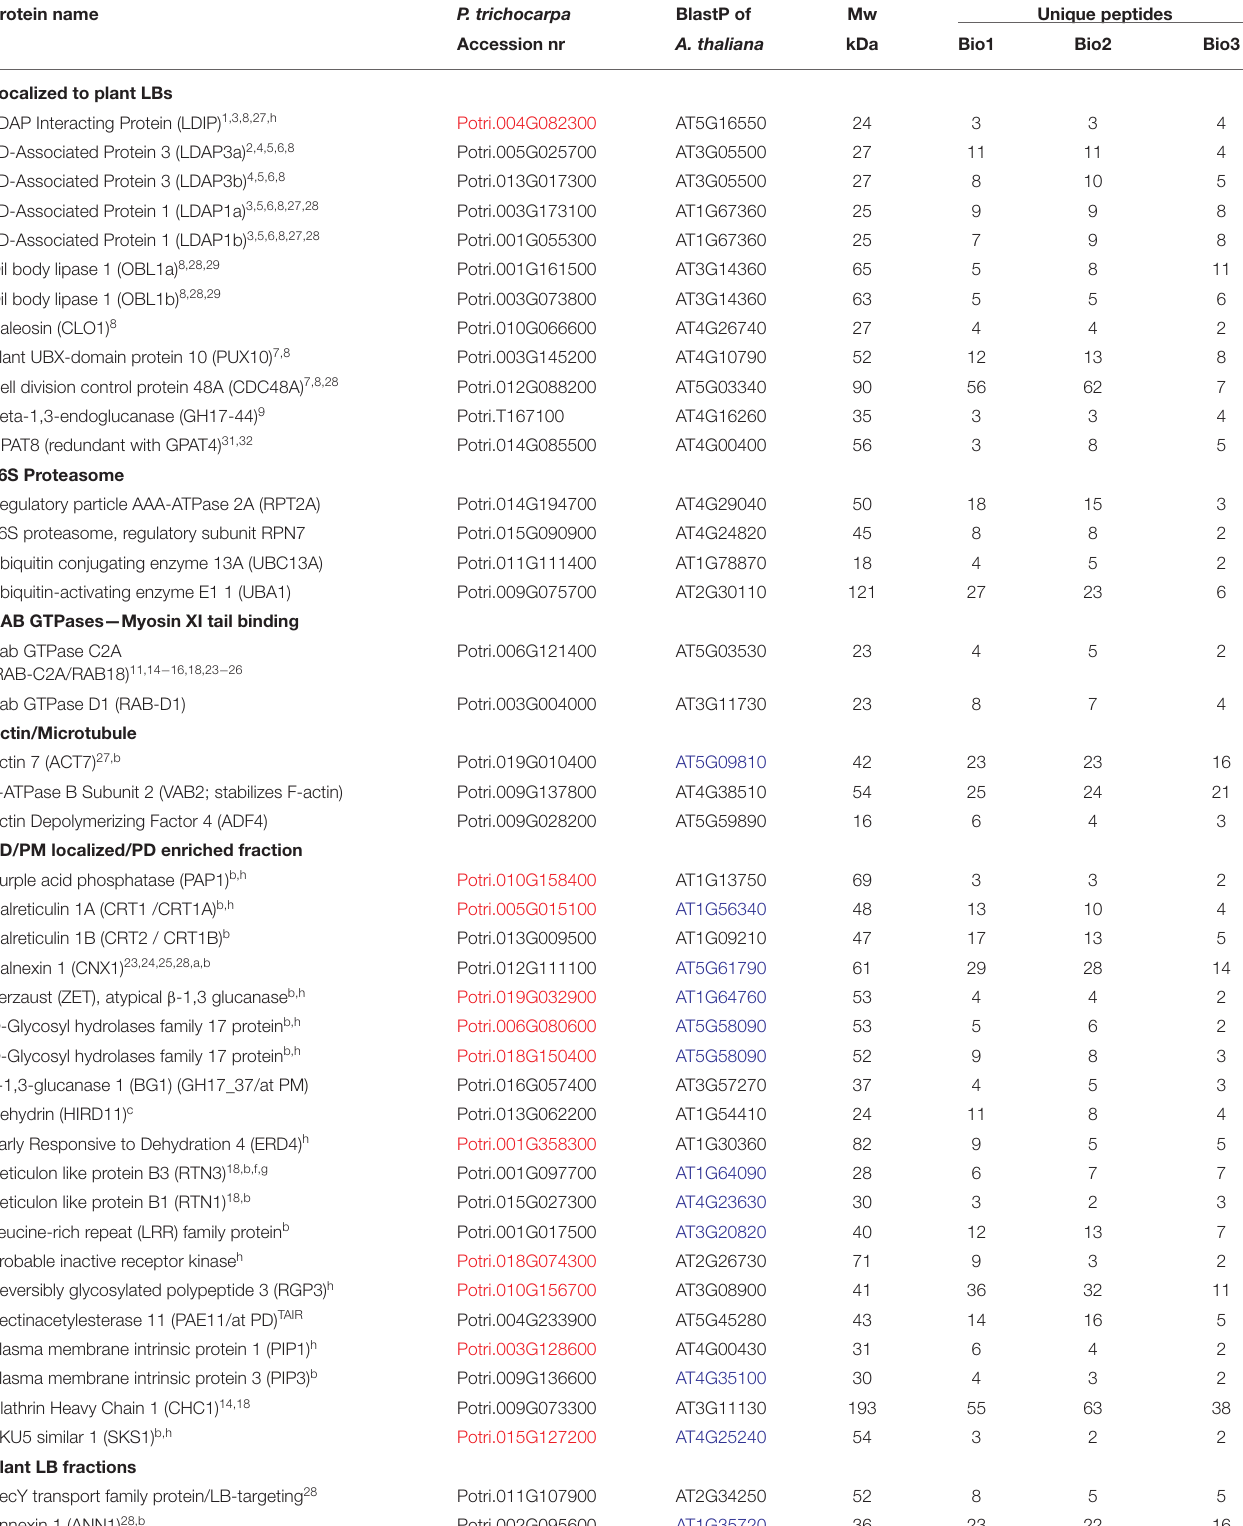
TABLE 1 | Proteins in the LB fraction, identical or similar to described putative LB/PD